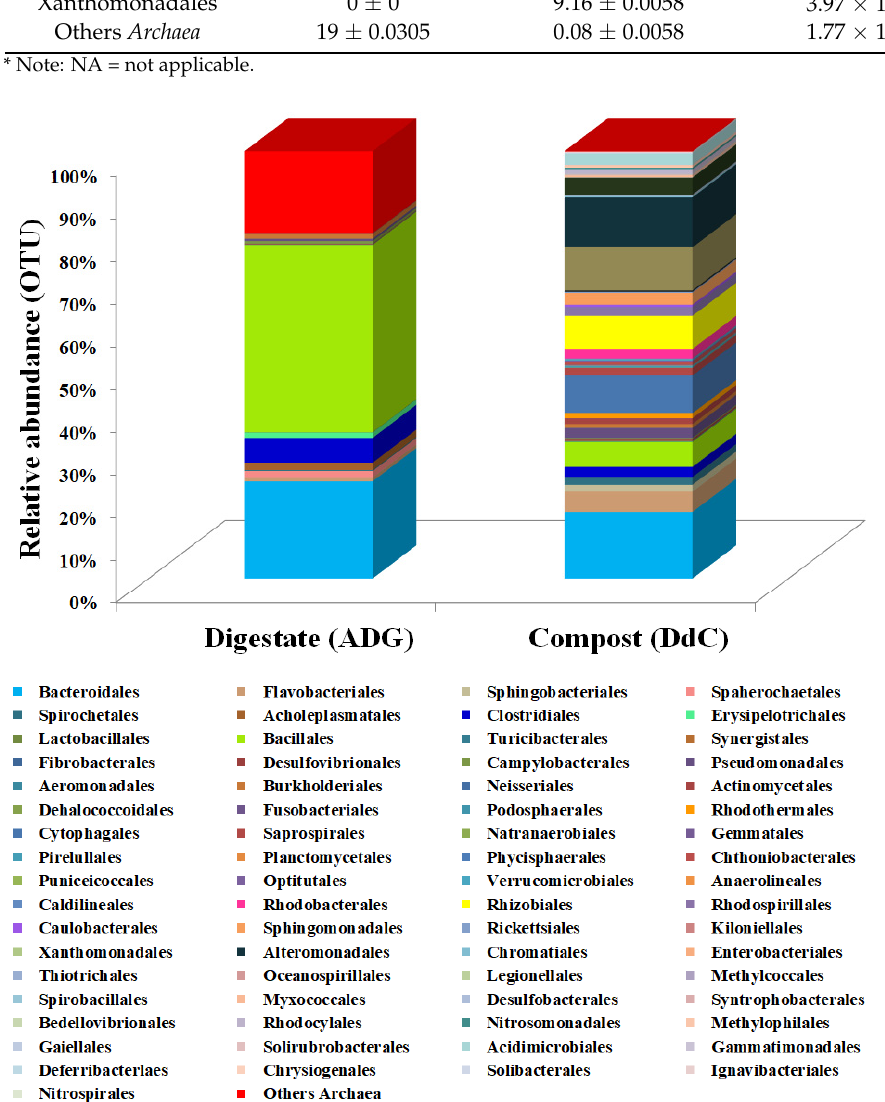
Figure 3. Microbioma composition (at order level) of the digestate (ADG) and the digestate-derived compost (DdC). The taxonomic profile is based on the sequencing of the 16S rRNA gene region. Unassigned 16S sequences were excluded. At order level, for all the microbiota found in the ADG and DdC, the mean values (±standard errors) of the relative abundance were calculated and reported in Table 2. In particular, the mean differences were statistically significant for the majority of the or-